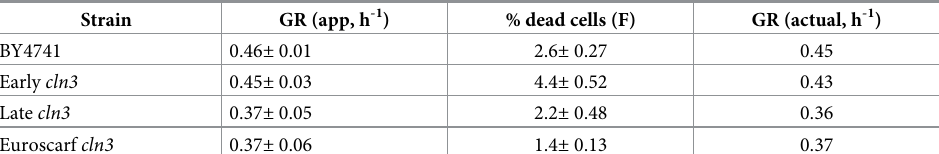
Table 1. Yeast strains’ growth